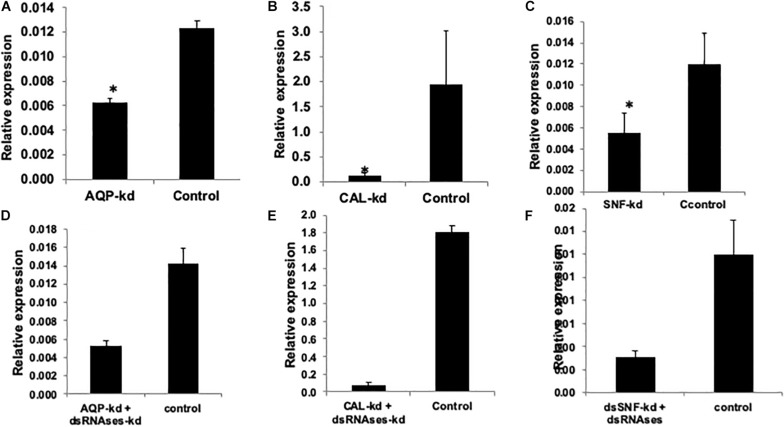
Relative expression of AQP, CAL, SNF, and IAP compared to GFP control when normalized with tubutin.
(A)
AQP knockdown (36.9%), (B)
CAL knockdown (93.27%), (C)
SNF 53.2%, (D)
AQP + dsRNAses knockdown (62.7%), (E)
CAL + dsRNAses knockdown (95.57%) (F)
SNF + dsRNAses 74.16% The error bar represents the standard deviation (n = 3) and *represents significant differences in mRNA transcripts compared to the control (P ≤ 0.05, Student’s t-test).